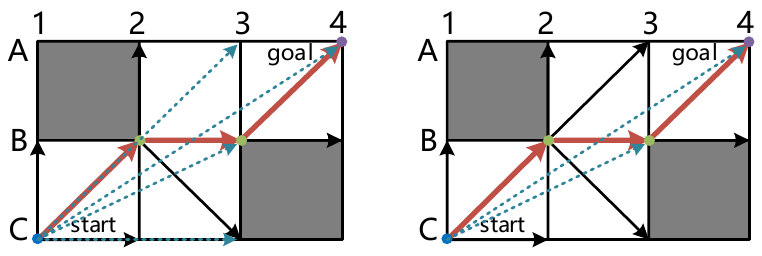
Figure 2. The extension processes of Theta* ( left ) and Lazy Theta* ( right ): the dashed lines are line-of-sight paths. Lazy Theta* performs less LoS-Check than